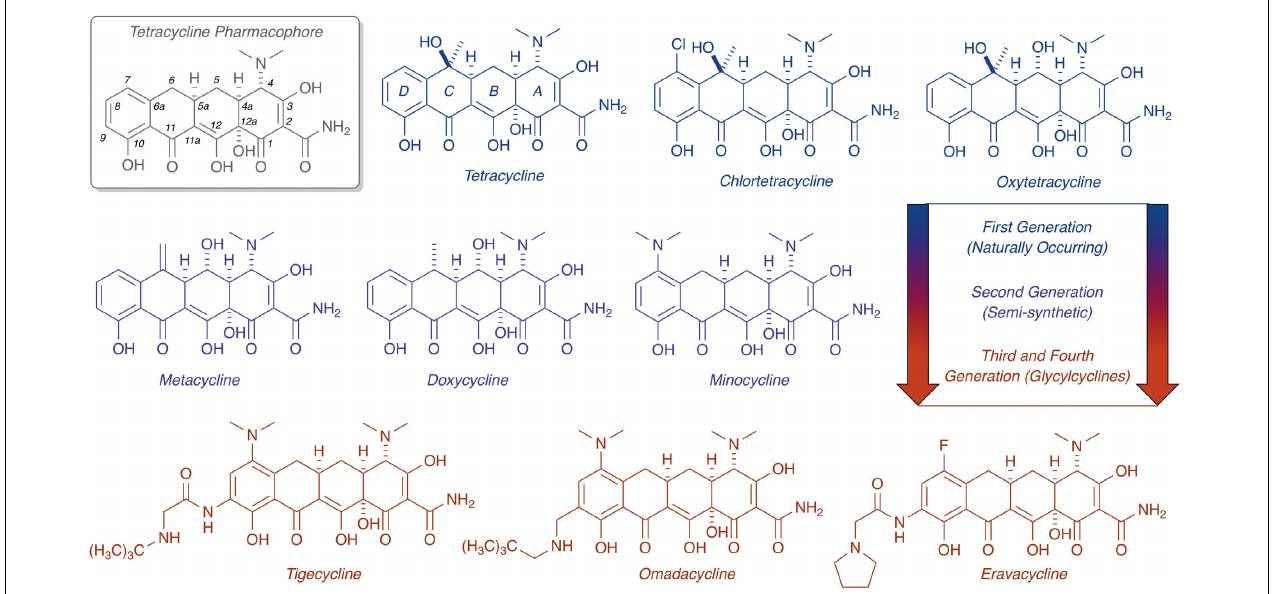
FIGURE 1 | Evolution of the tetracycline scaffold. 6-Deoxy-6-demethyltetracycline represents the minimum tetracycline pharmacophore required for inhibition of the ribosome. Tetracycline (first reported in 1953), CTc (first reported in 1948), and oxytetracycline (first reported in 1950) represent first generation structures. Metacycline (first reported in 1962), doxycycline (first reported in 1967), and minocycline (first reported in 1961) represent second generation structures. Tigecycline (first reported in 1993) is the only FDA-approved third generation structure, while omadacycline (first reported in 2013) and eravacycline (first reported in 2013) are fourth generation molecules currently in phase III clinical